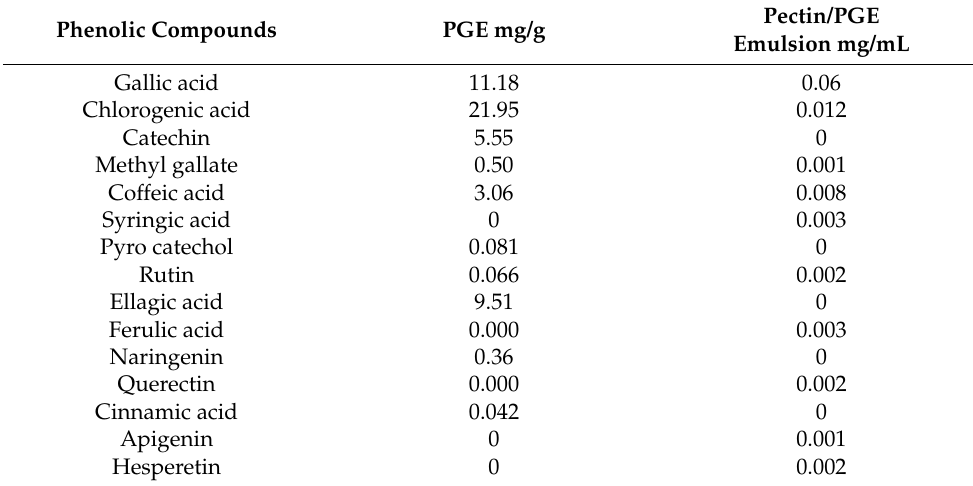
Table 5. Phenolic compounds of PGE and Pectin/PGE emulsion determined by high-performance liquid chromatography